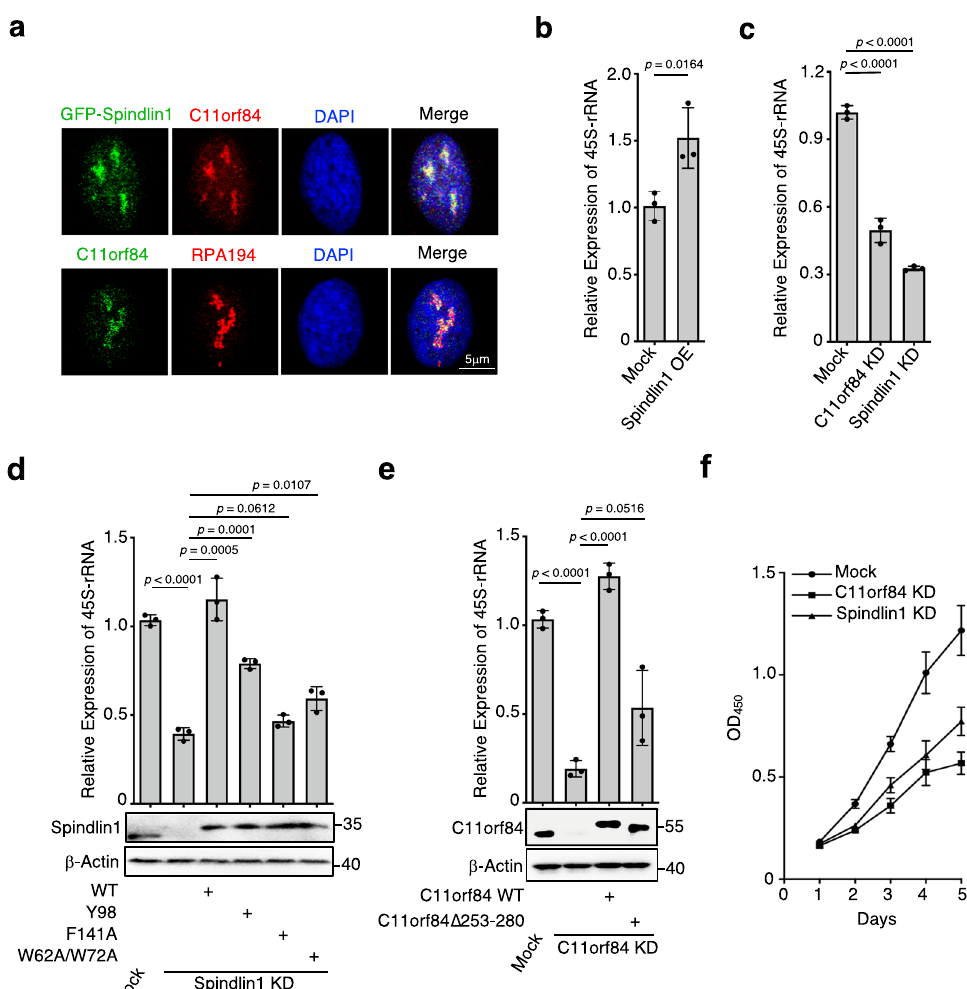
Fig. 3 Binding to C11orf84 and H3K4me3K9me3 is required for Spindlin1 to stimulate rRNA transcription. a C11orf84 colocalizes with Spindlin1 and RPA194 in the nucleolus. C11orf84 and RPA194 were visualized by indirect immuno fl uorescence whereas GFP-Spindlin1 by direct fl uorescence. Nuclei were stained with DAPI. Scale bar: 5 μ m. b Overexpression of Spindlin1 stimulates rRNA transcription. The 45S pre-rRNA level was determined by RT-qPCR in HEK293T mock cells and Spindlin1-overexpressed (Spindlin1 OE) cells. c RT-qPCR reveals that depletion of Spindlin1 or C11orf84 results in a reduced level of 45S pre-rRNA transcript in U2OS cells. d Ectopic expression of wild-type Spindlin1 but not the mutated forms that impaired the binding to either K4me3 or K9me3 of histone H3 restored the rRNA transcription level in Spindlin1 stable knockdown U2OS (Spindlin1 KD) cells. RT-qPCR was performed to determine the level of 45S pre-rRNA. Western blot shows the level of Myc-tagged wild type and mutant Spindlin1. e Ectopic expression of wild-type C11orf84 but not the truncated form that impaired the binding to Spindlin1 restored rRNA synthesis in C11orf84 stable knockdown U2OS (C11orf84 KD) cells. b – e Data are shown as mean ± SD ( n = 3 independent repeated experiments). The p values were calculated by two-tailed unpaired t -test. f Knockdown of Spindlin1 or C11orf84 inhibits cell proliferation. Cell number was counted by Cell Counting Kit-8 (CCK-8) on a daily basis for a period of 5 days. Data are presented as mean ± SD ( n = 5 independent experiments). The p values were calculated with two-way ANOVA test followed by Dunnett ’ s multiple comparisons test. Spindlin1 KD versus Mock, p values are 0.0036, 0.0005, 0.0045, and 0.004, respectively from day 2 to day 5; C11orf84 KD versus Mock, p values are 0.0019, 0.0004, 0.0004, and <0.0001, respectively, from day 2 to day 5. Source data are provided as a Source Data fi